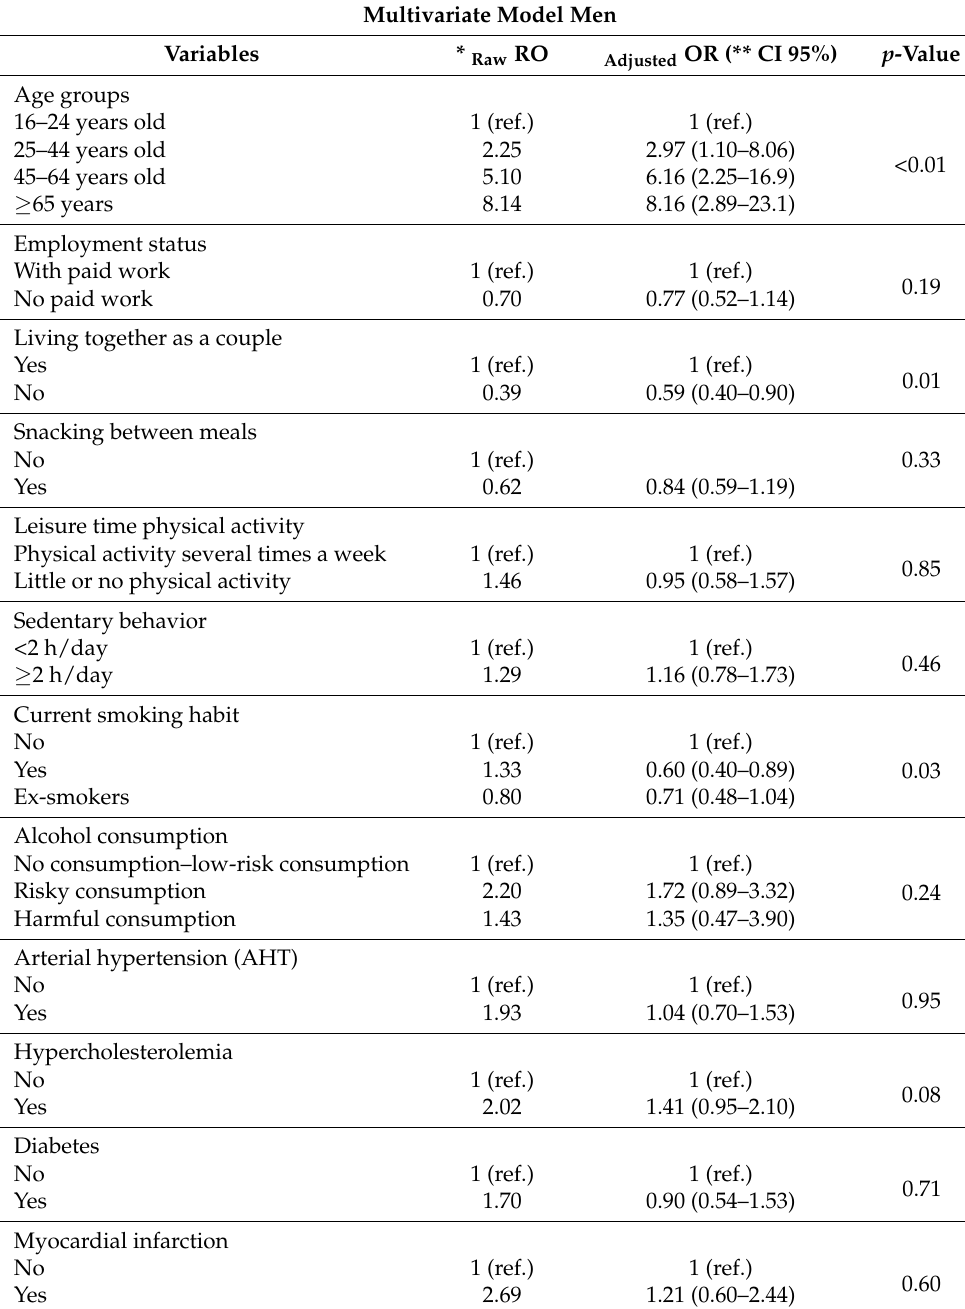
Table 6. Multivariate analysis of risk factors related to high adherence to the Mediterranean diet in adult men in southeastern